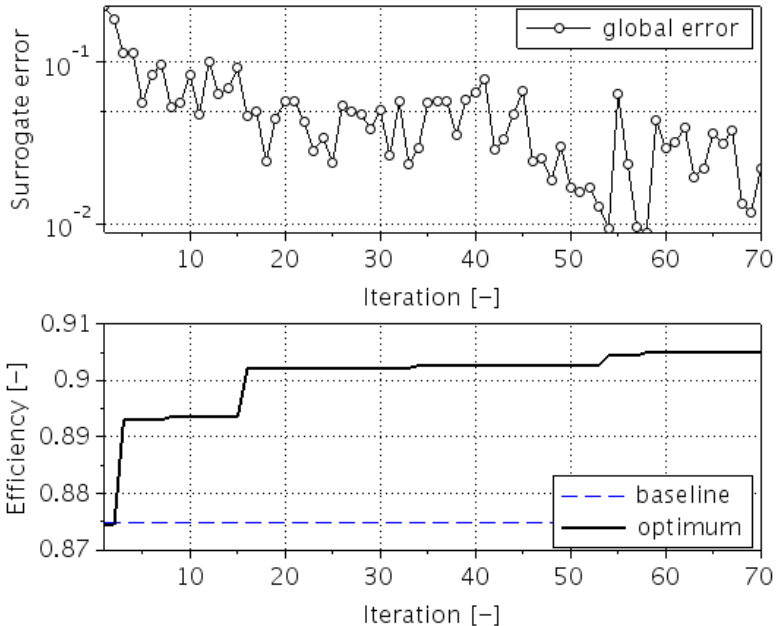
Figure 13. Convergence of the optimization strategy: global error ( top ) and maximum efficiency ( bottom